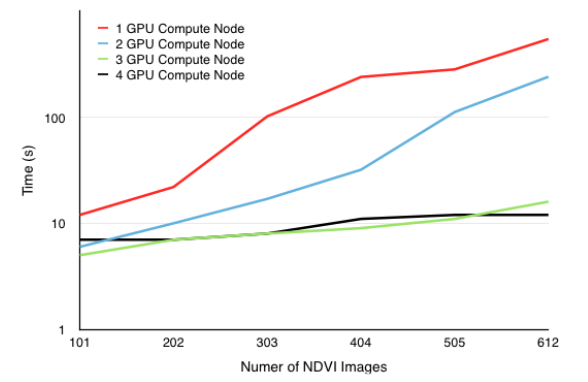
Figure 4. Path Discovery Hadoop